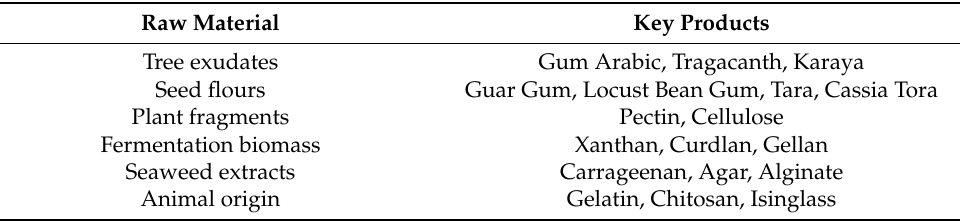
Table 3. Sources of hydrocolloids and the products derived from them. Adapted and sourced from: www.cybercolloids.net (accessed on: 5 November 2021) [63].